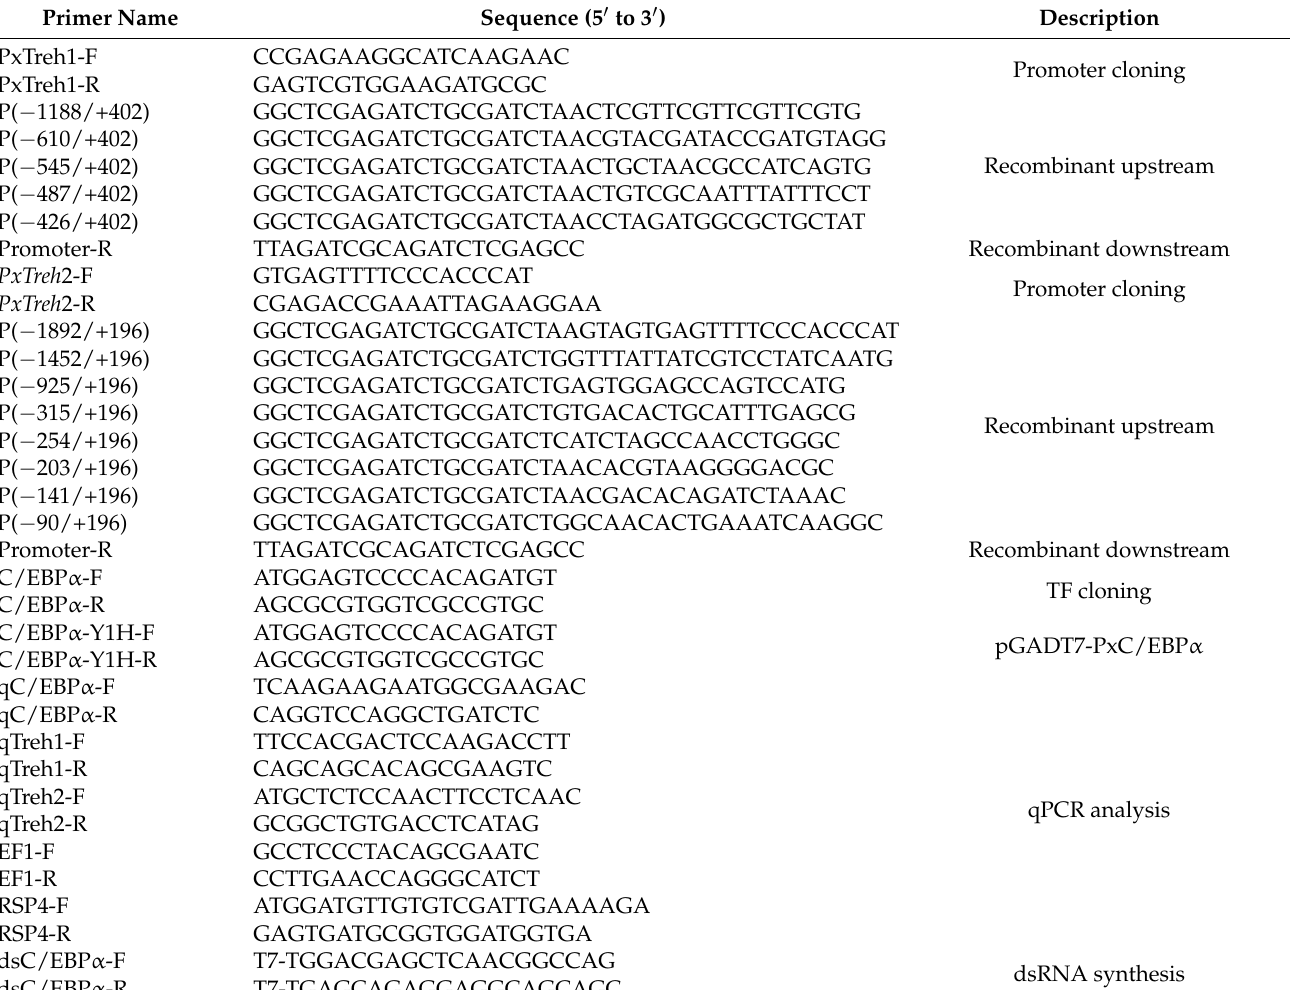
Table 1. Oligonucleotide primers used in this